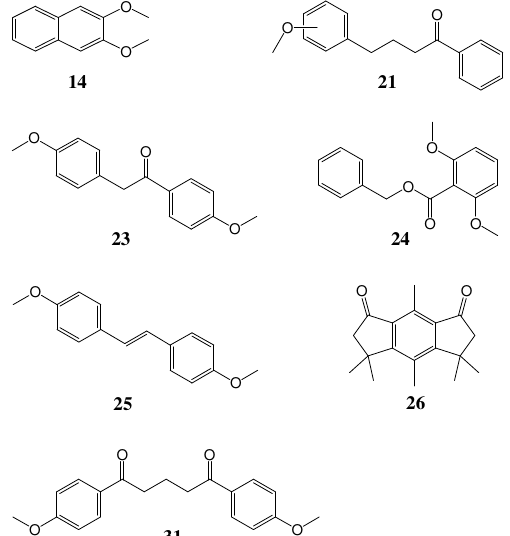
Figure 2 . Structures of aromatic compounds reported as honey constituents for the first